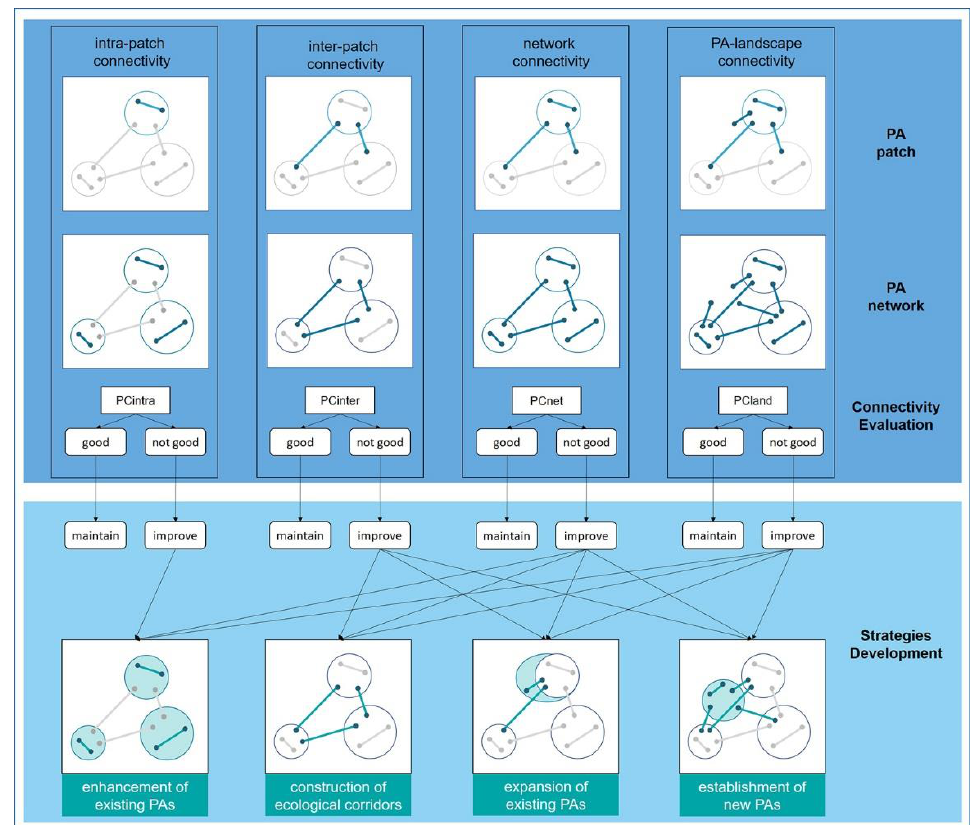
Figure 1. A framework for protected area (PA) connectivity evaluation and strategy development based on connectivity indicators and conducted from four perspectives: intra-patch, inter-patch, network and PA–landscape connectivity.